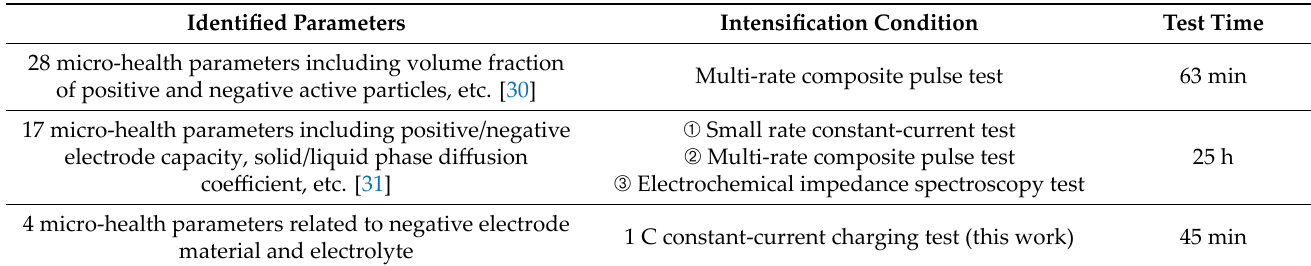
Table 4. Comparison of test time under different identification conditions.